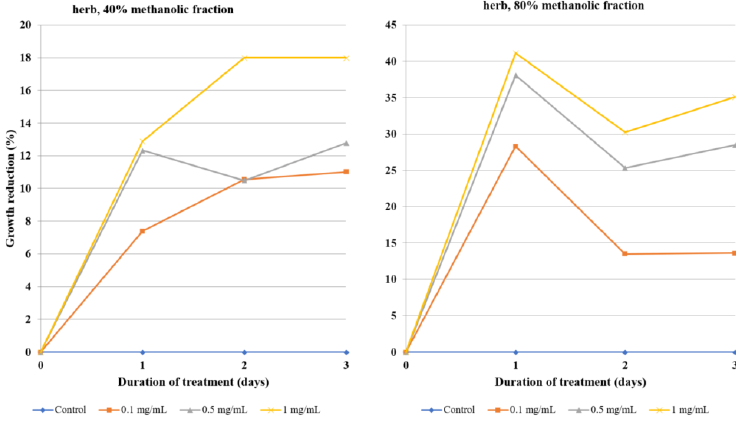
Figure 4. The effect of the 40% and 80% methanolic fractions of extract from the flowering herb of Lychnis flos-cuculi on the inhibition of Acanthamoeba trophozoite proliferation in the culture medium. Table